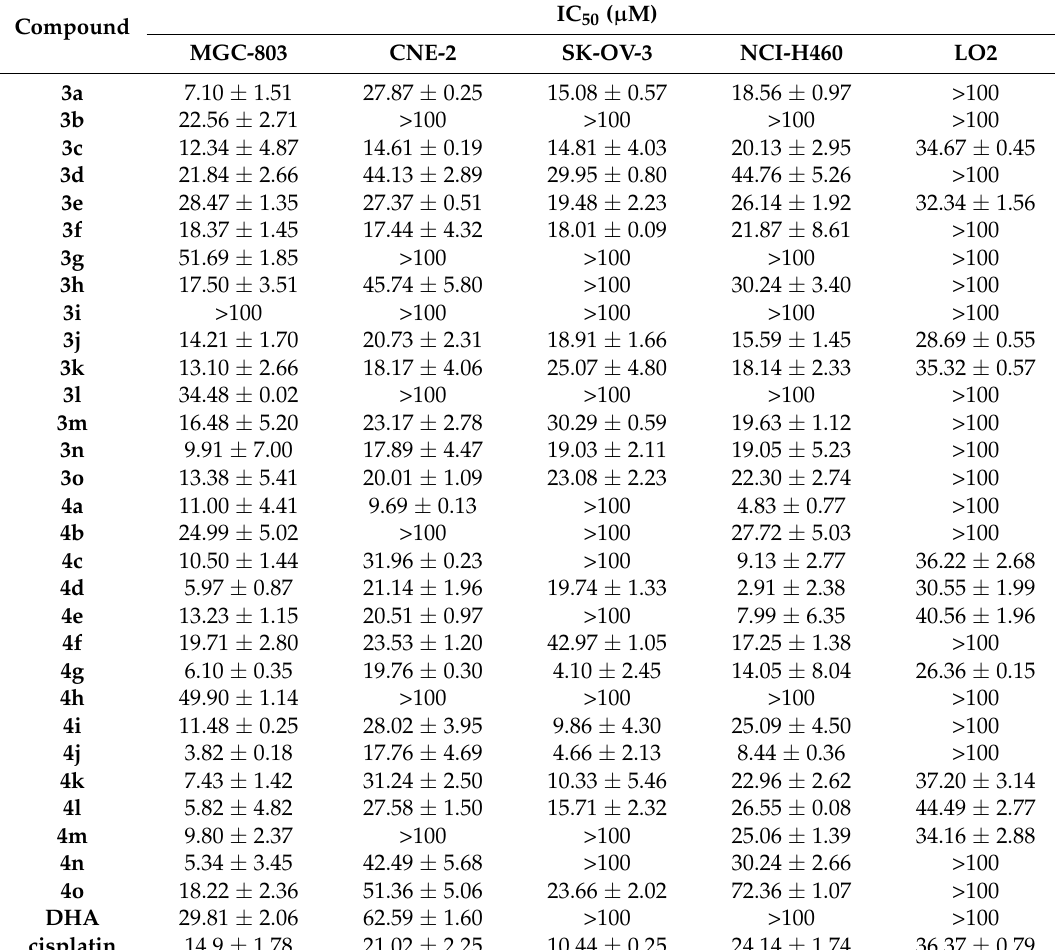
Table 1. Effect of compounds 3a – o and 4a – o against on the cell viability of different cell lines a .